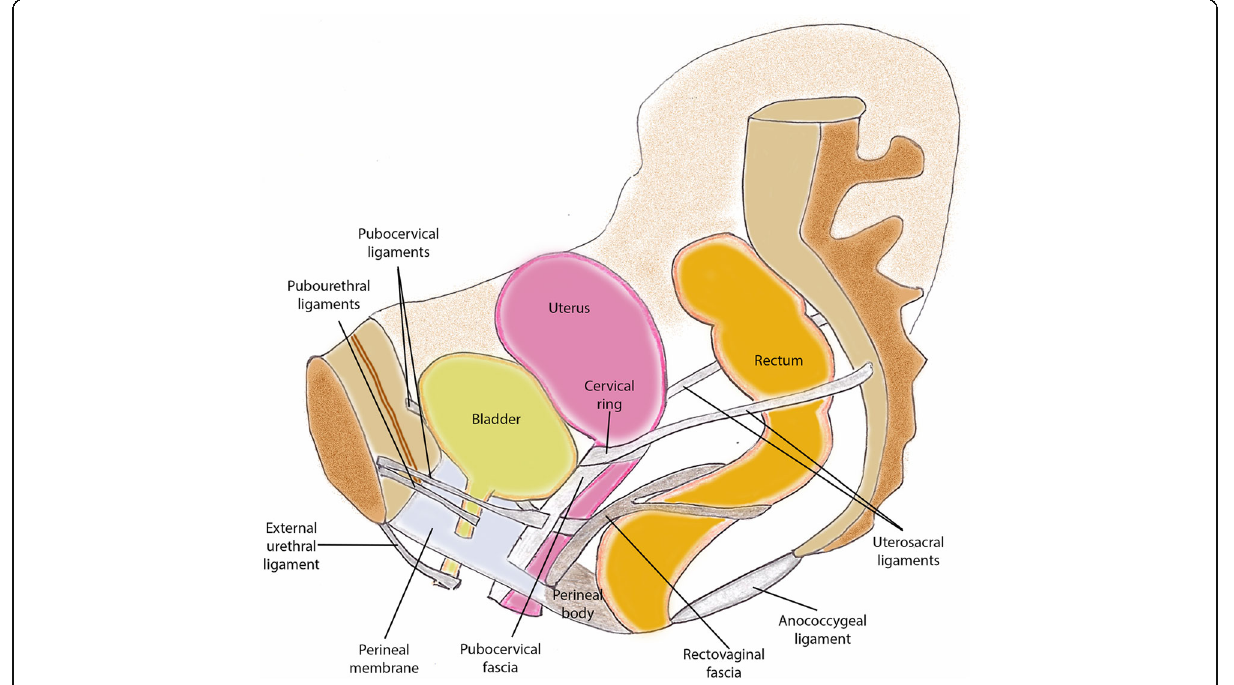
Fig. 3 Representative image of the pelvic floor ligaments and their relative anatomical positions in a female model